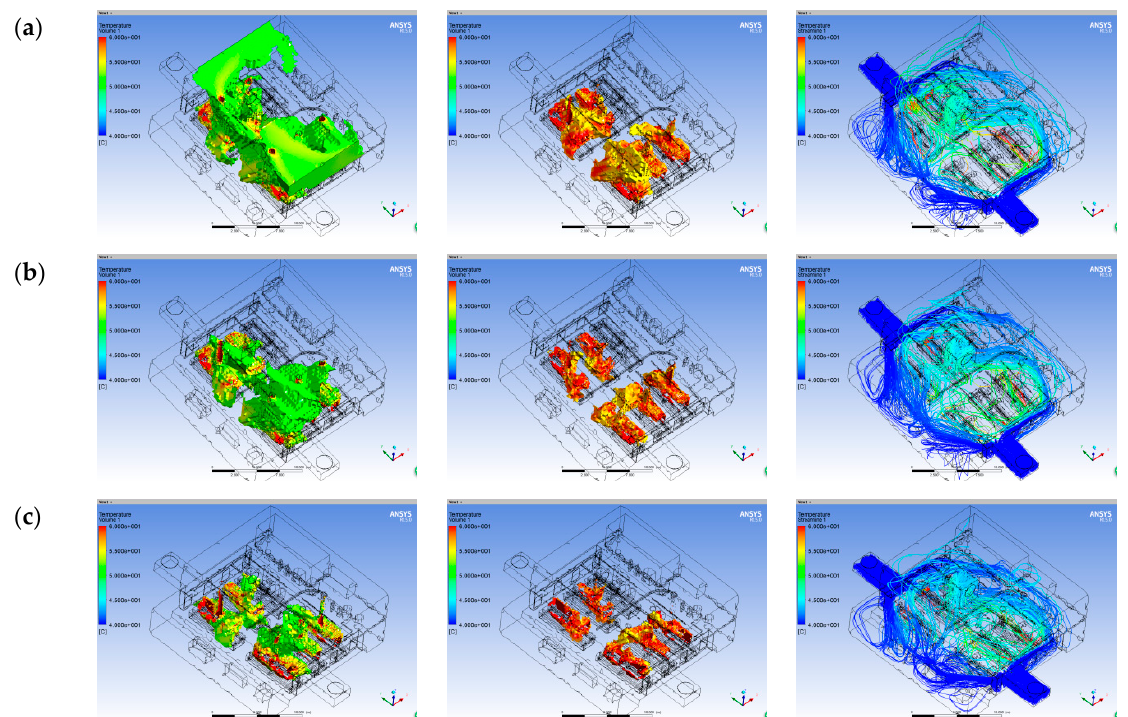
Figure 8. High-temperature volumes above 50 and 55 °C, and temperature streamlines between 45 and 60 °C in the conditions of ( a ) ventilation temperature 40 °C with 0.75 nominal volume, ( b ) 40 °C with nominal volume, and ( c ) 40 °C with 1.25 nominal volume.